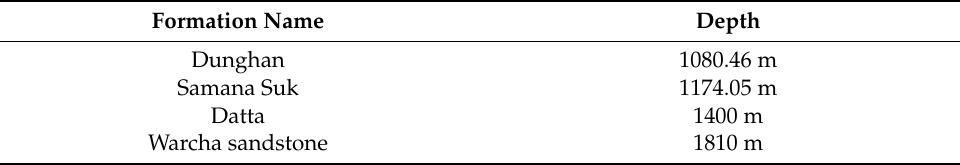
Figure 2. ( a ) Base map of the study area. ( b ) Time-depth (TD) chart of the study area. Table 4. Formation top values of marked reflectors. Table 4. Formation top values of marked reflectors.